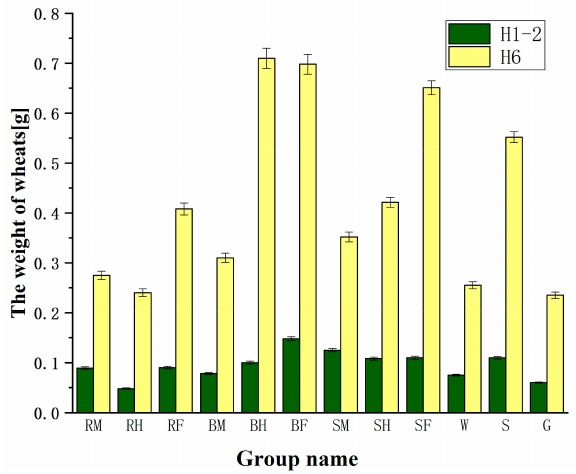
Figure 12. The weight of wheats plants (both H 1-2 and H 6 ) cultivated in different conditions.